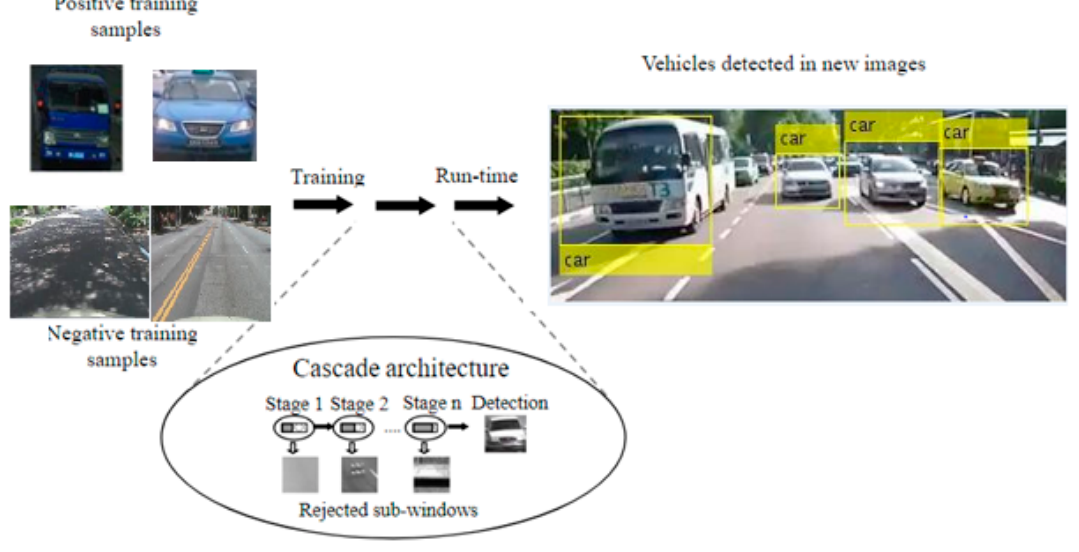
Figure 6. Example of a cascade for detecting a vehicle.